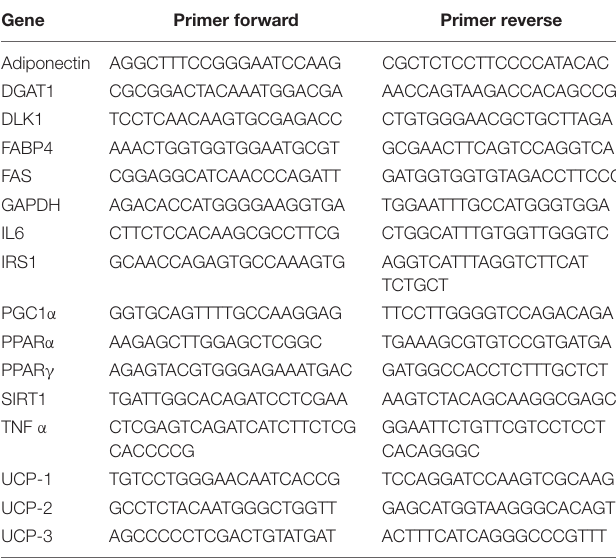
TABLE 1 | PCR primers used in this